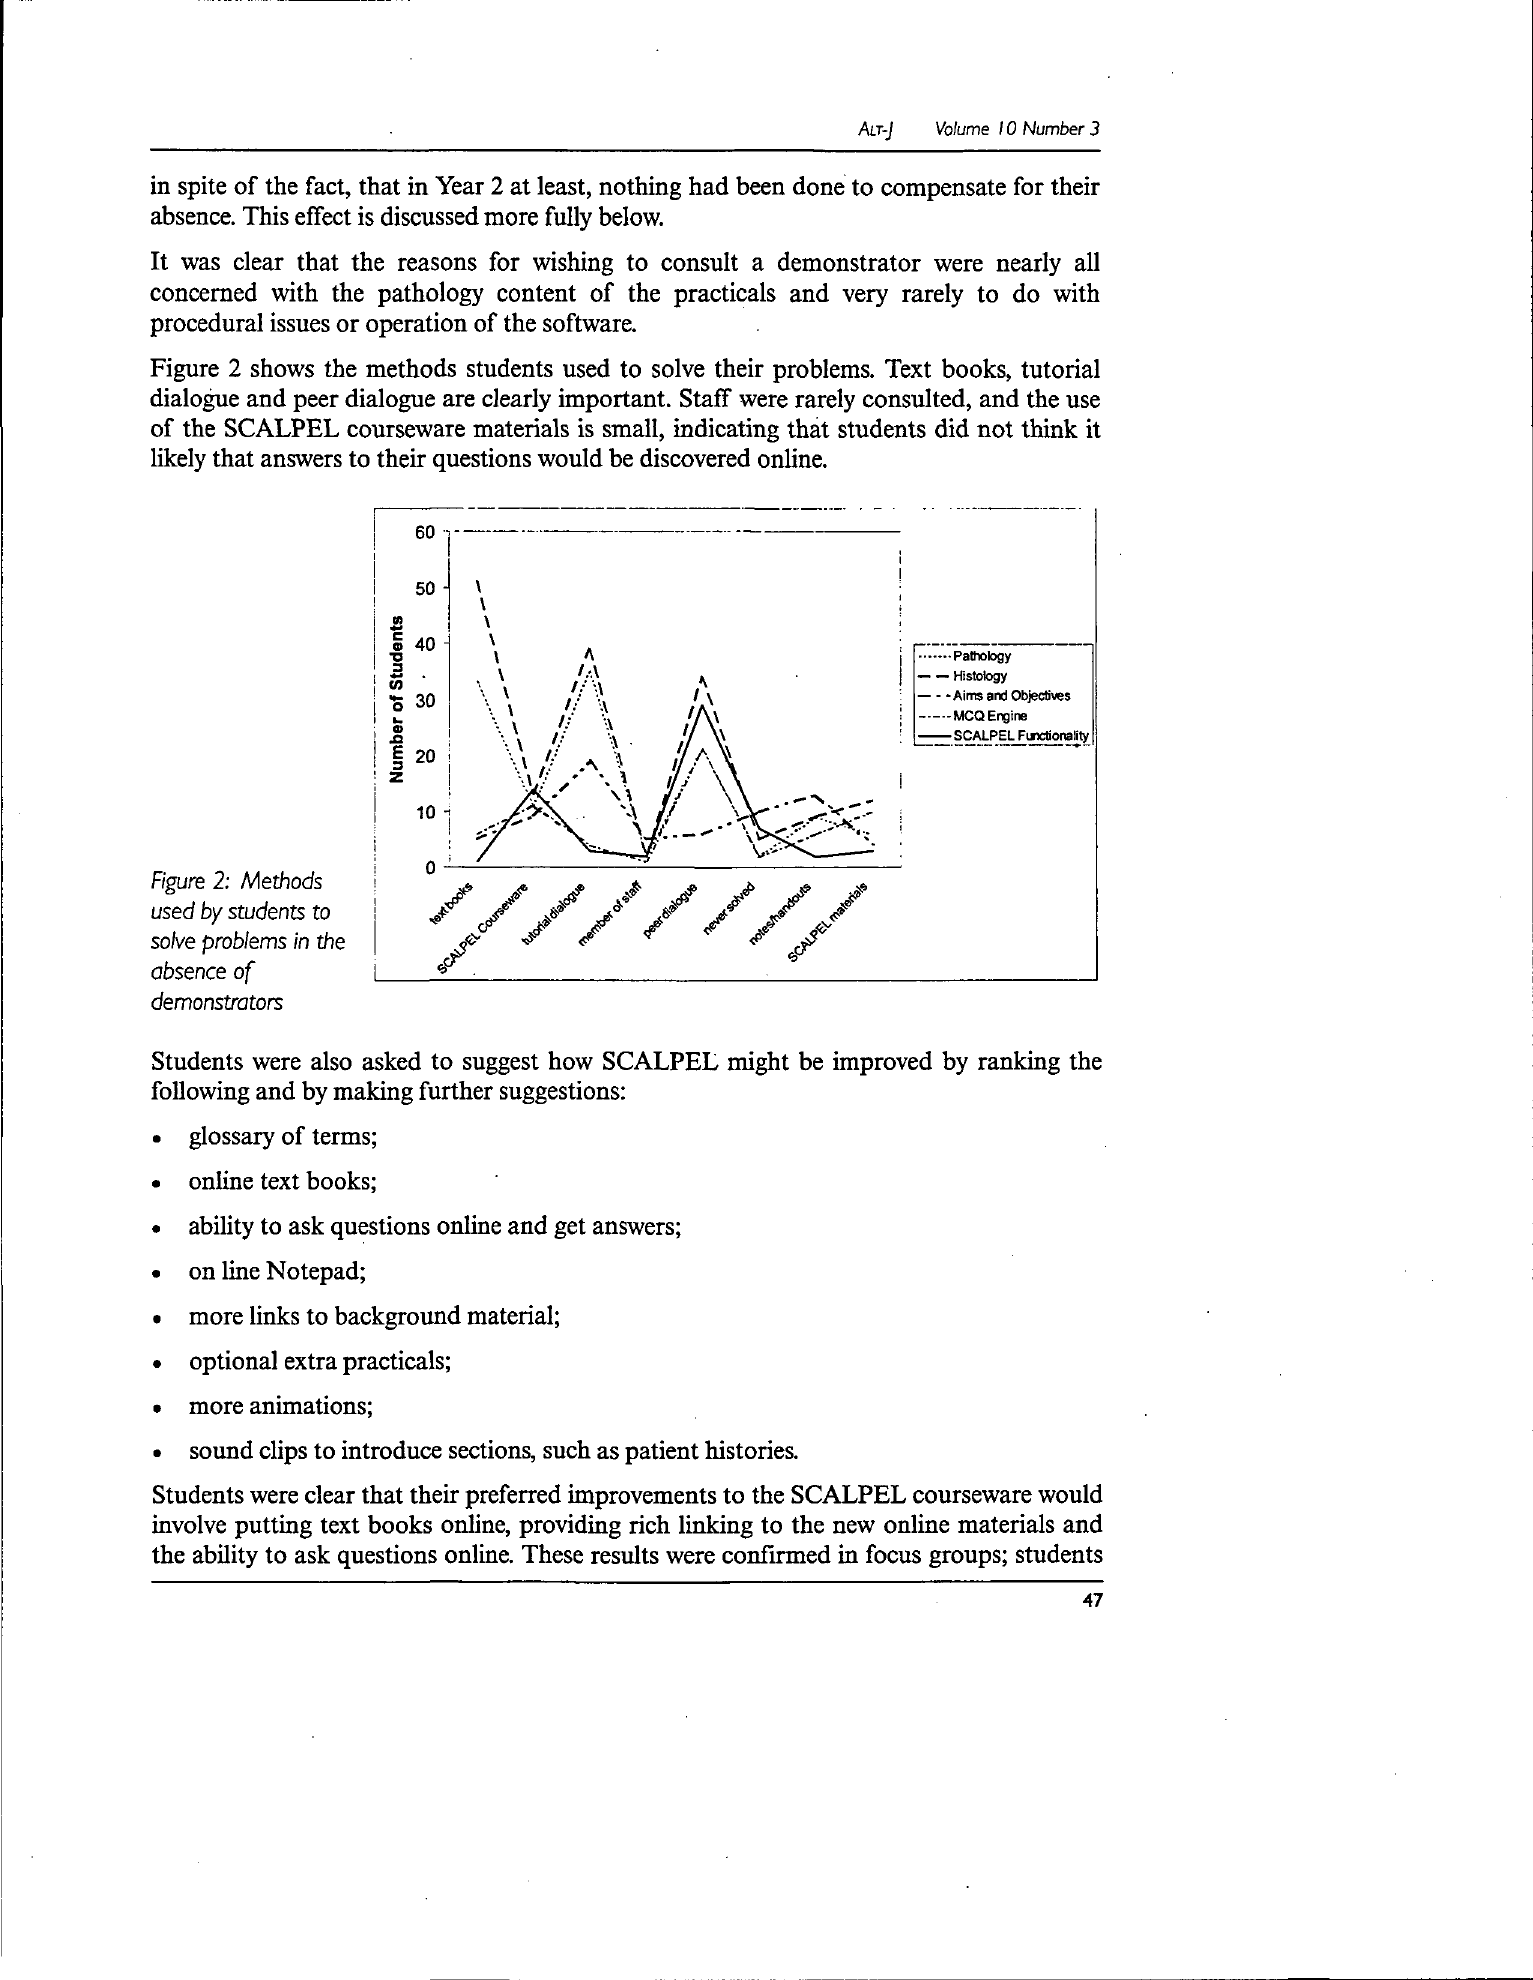
Figure 2: Methods used by students